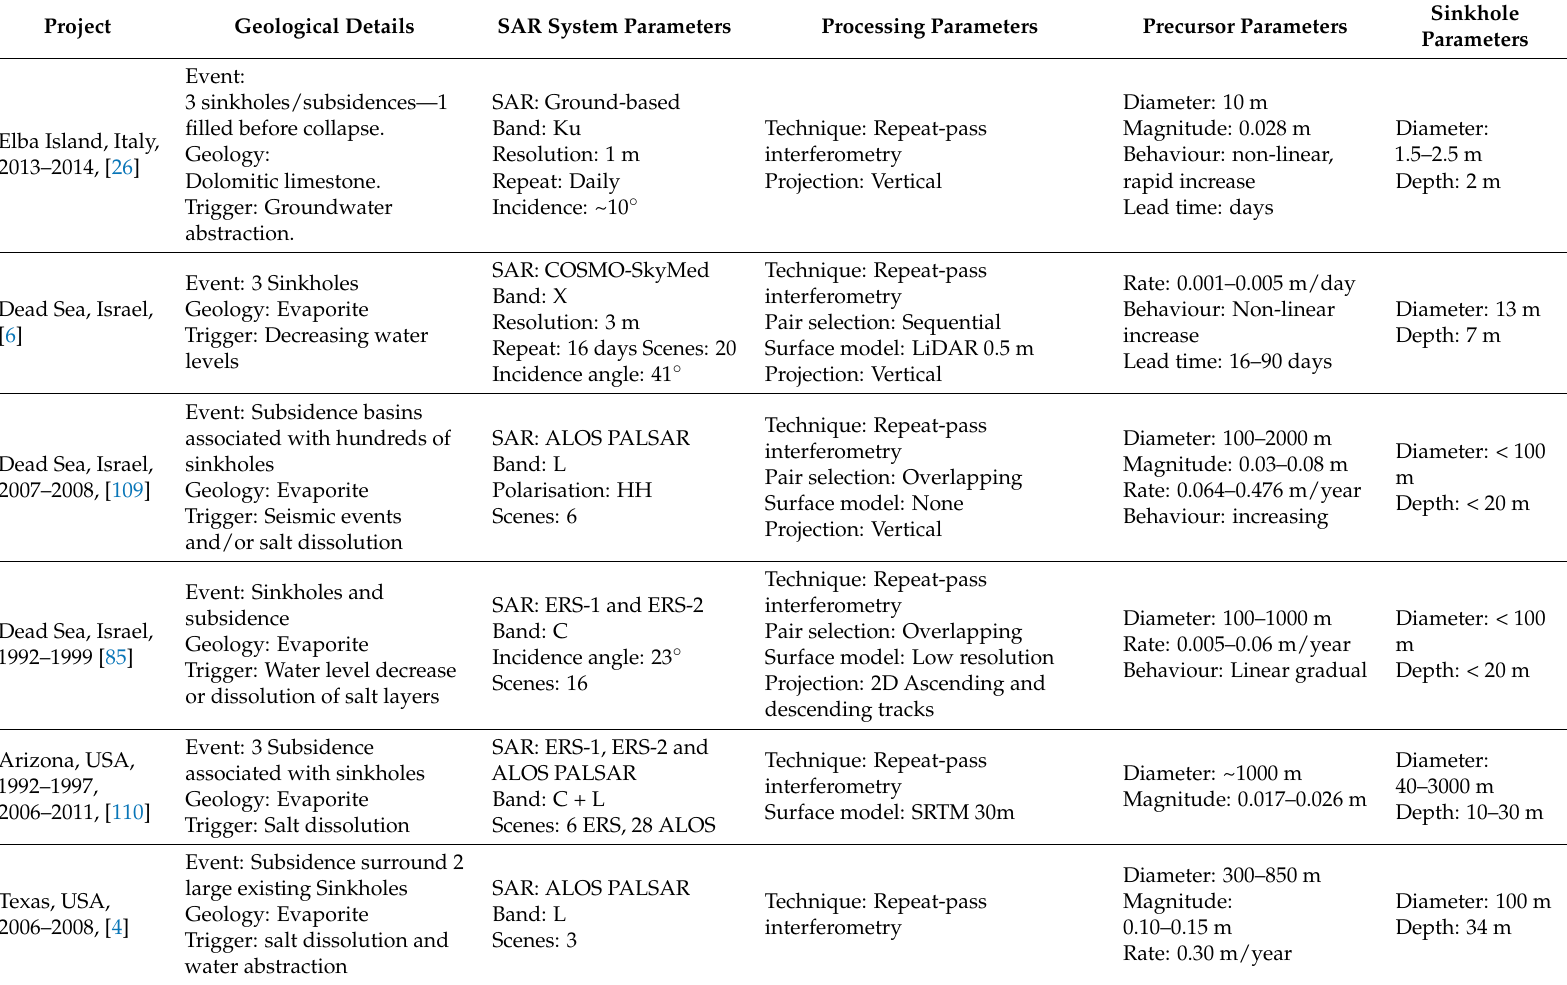
Table 1. Summary of investigations for which precursors to sinkhole development were successfully